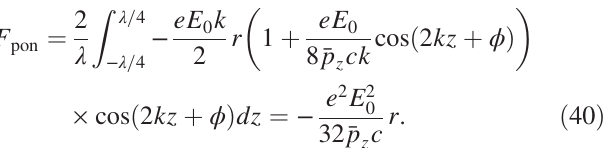
FIG. 10. Transverse momentum versus start phase for a 1 1 rf gun cavity (1.3 GHz, E 0 ¼ 50 MV = m). The particle starts at the cathode with an offset of 1 mm. The solid line shows the result of a numerical integration, while the dashed line displays the result in accordance to Eq.